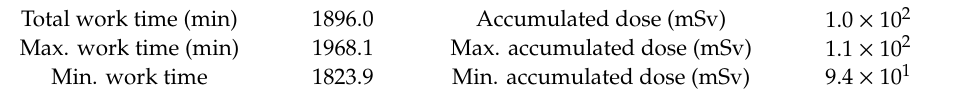
Table 3. Work time and estimated dose for the fragmentation of the upper part.